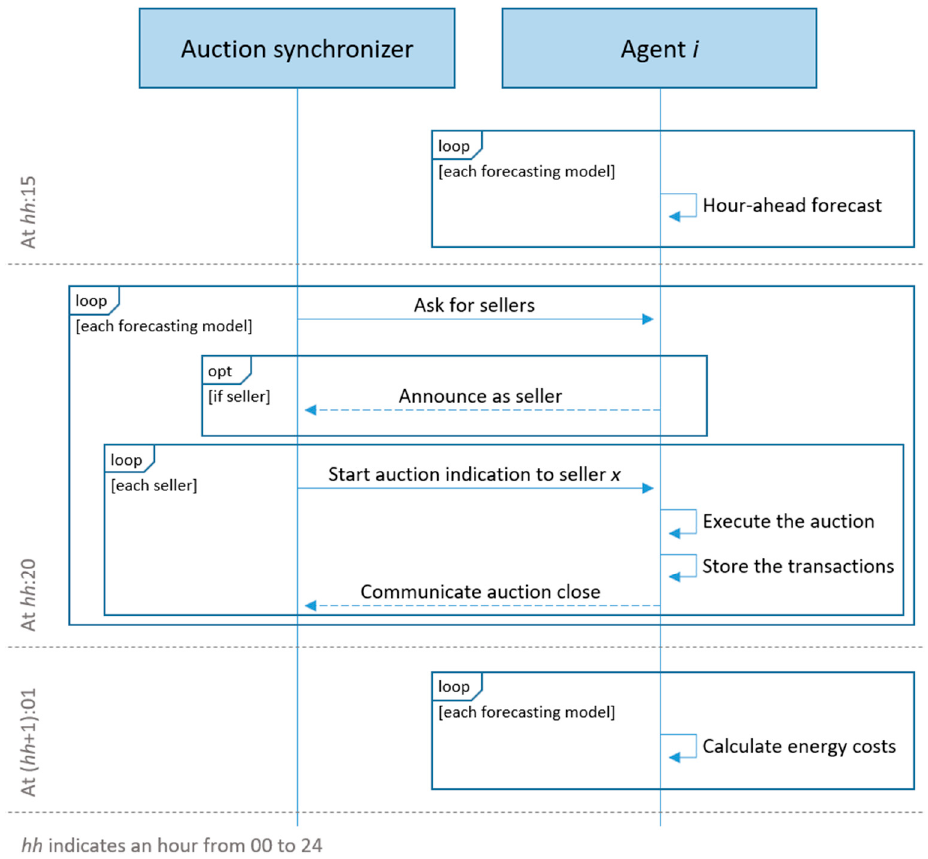
Figure 6. Sequence diagram of forecasting and P2P actions.